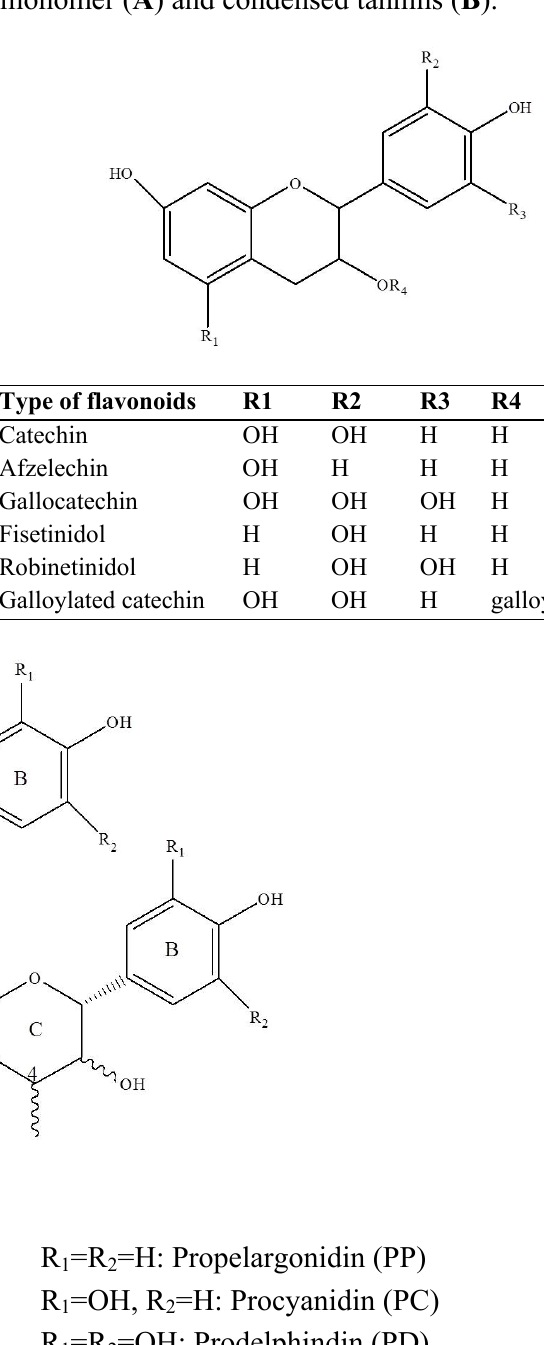
Figure 1. Chemical structures of a flavan-3-ol monomer ( A ) and condensed tannins ( B ).